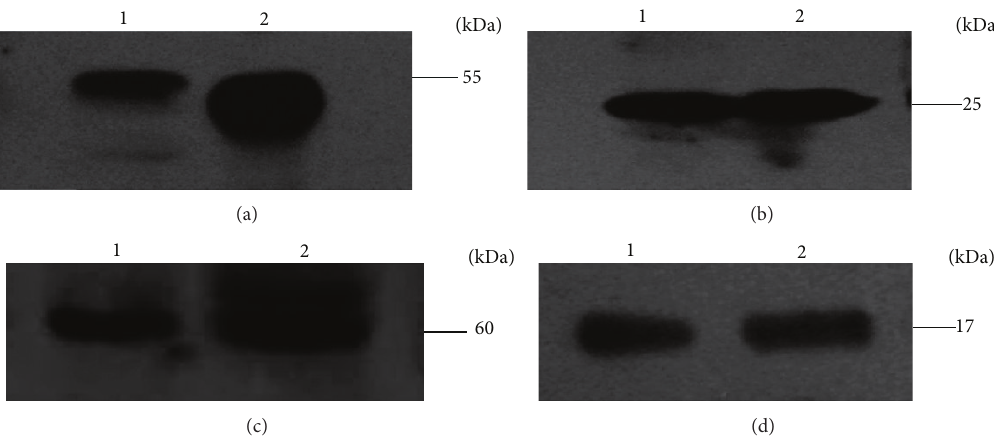
Figure 3: Western blot analysis of recombinant SIgA under reduced conditions. Transferred proteins were incubated with various specific primary antibodies. (a) Mouse anti-human IgA 𝛼 -chain. (b) Mouse anti-human 𝜅 -chain. (c) Mouse anti-human SC. (d) Mouse anti-human J chain. HRP-conjugated goat anti-mouse IgG was used as secondary antibody. Lane 1: human saliva (positive control); 2: produced